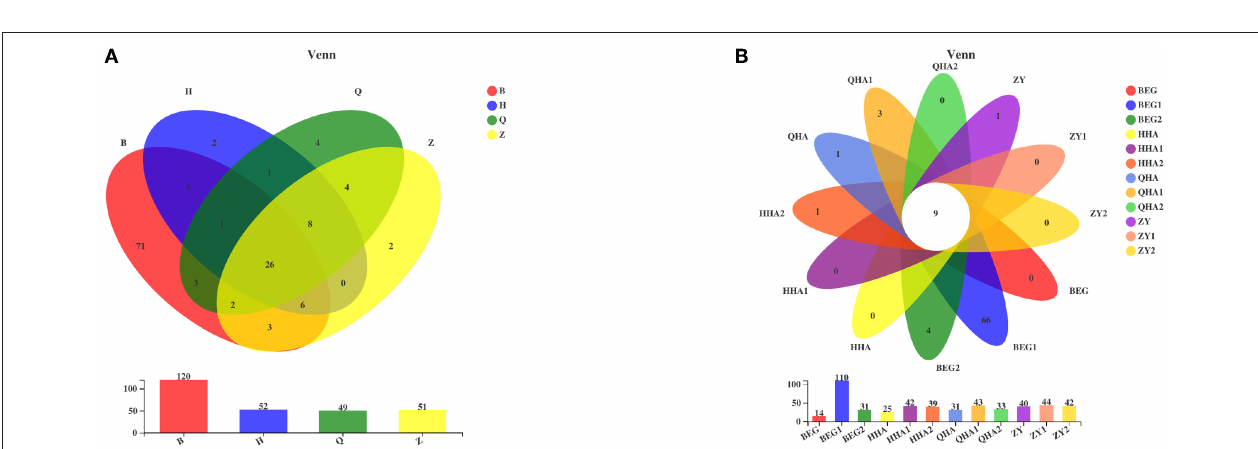
FIGURE 4 | Venn diagrams. (A) Venn diagram of OTU in 4 places of Mongolia is analyzed according to bacterial microbial diversity. (B) Venn diagram of OTU of each sample is analyzed according to bacterial microbial diversity.